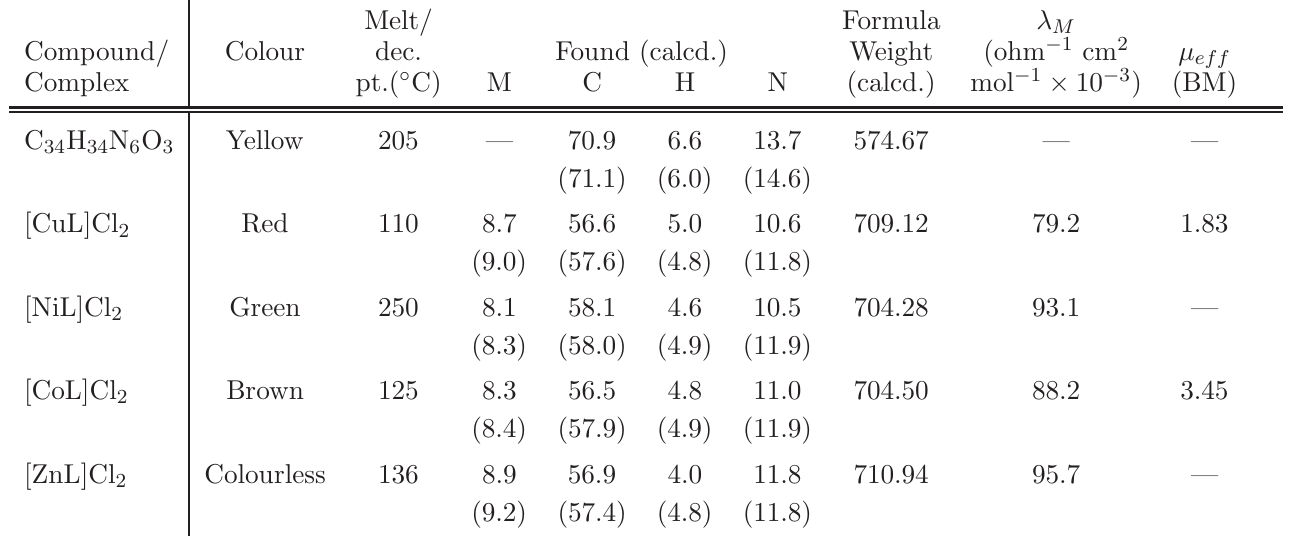
Table 1 Physical and analytical data of the synthesized